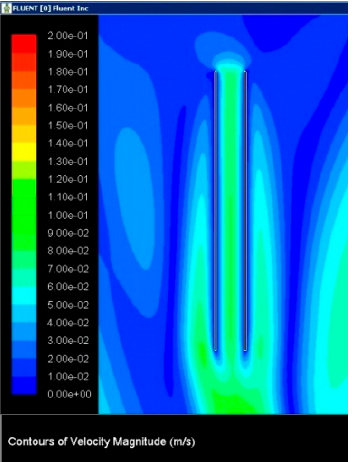
Figure 16. The contours of velocity (m/s) at spacing of 7 mm and rib height 70 mm.